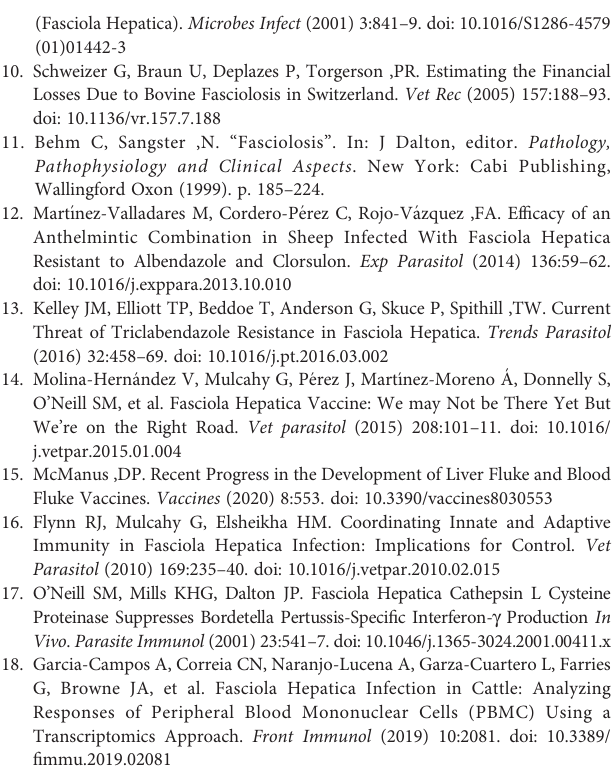
Supplementary Table S7 | IPA canonical pathways in PBMC at acute and chronic stages of F. hepatica infection in sheep and cattle. – log(p-value) - The probability of association of genes from our dataset with the canonical pathway by random chance alone using Fisher ’ s exact test. z-score - Overall activity status of thepathway.Z<0indicatesaprediction ofanoveralldecreaseinactivitywhileZ>0 predicts an overall increase in the activity. NA indicates pathways that are currently ineligible for a